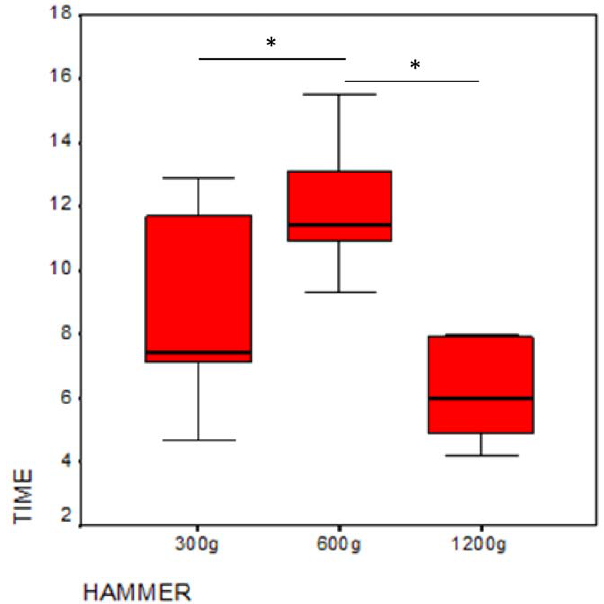
Figure 3. Median time needed to crack open a nut as a function of hammer weight in Experiment